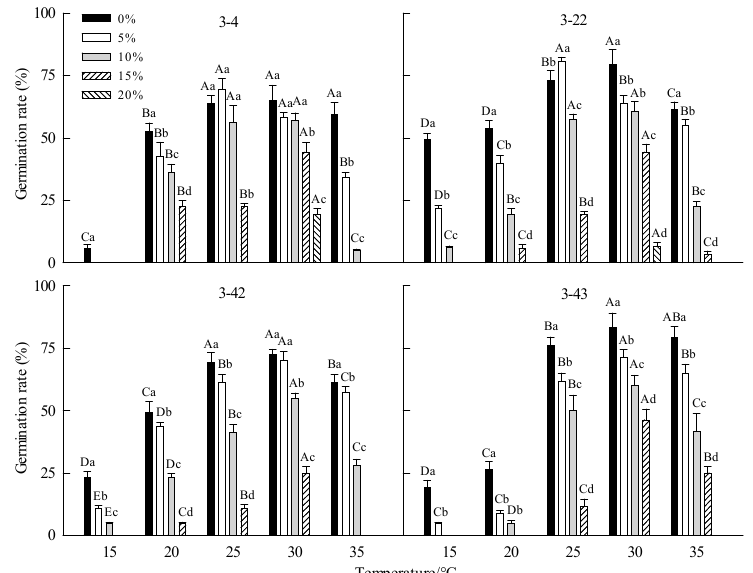
Figure 1. Effect of drought stress on seed germination percentage of Betula platyphylla Suk. in different families under different temperatures. Different capital letters stand for significant differences between different temperatures of the same PEG concentration ( p < 0.05), and different lowercase letters stand for significant differences between different PEG concentrations at the same temperature ( p < 0.05); 0%, 5%, 10%, 15%, and 20% represent different concentrations of PEG; 3-4, 3-22, 3-42, 3-43 represent different families of Betula platyphylla seeds; Data are shown as mean ± Sd ( n = 4).